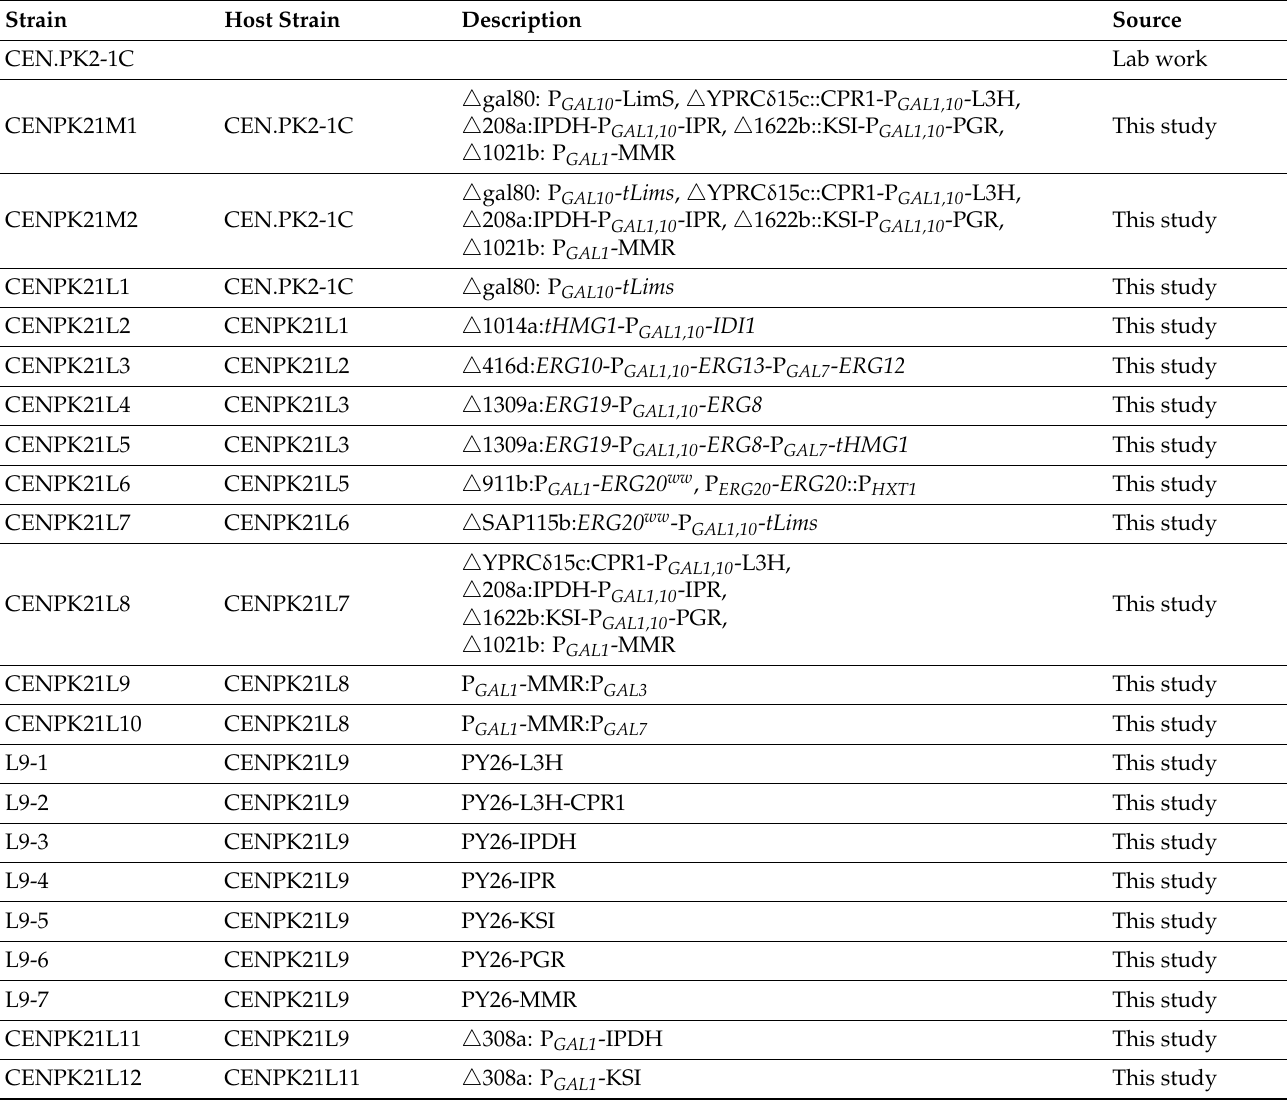
Table 1. Saccharomyces cerevisiae strains used in this